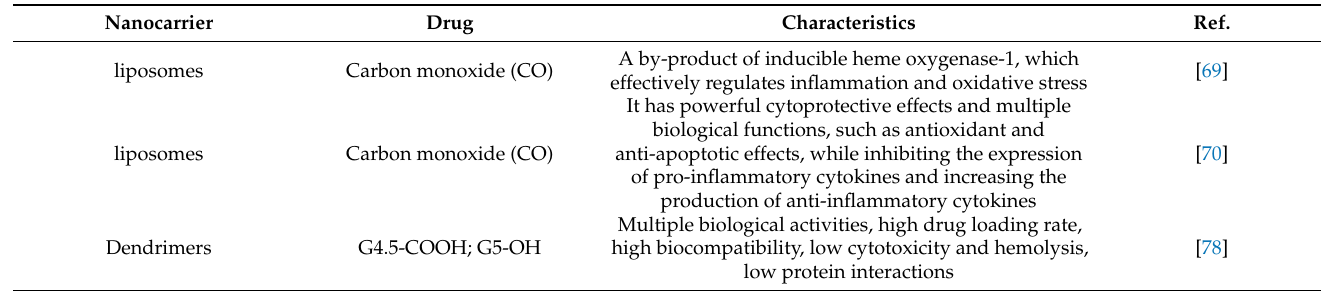
Figure 4. ( a ) Schematic diagram of bilirubin-loaded silk fibroin nanoparticles (BRSNPs) for the treatment of experimental AP. ( b ) Schematic representation of the antioxidant and anti-inflammatory mechanisms of BRSNPs in pancreatic alveolar cells. ( c ) MDA levels in rats after treatment of AP in the BRSNPs group and all other groups. ( d ) SOD levels in rats after treatment of AP in the BRSNPs group and all other groups. && p < 0.01 compared with BR group. ** p < 0.01 compared with model group. ^^ p < 0.01 compared with normal control rats. Reprinted from [88]. Copyright 2020, with permission from Elsevier. Table 1. Nano-drug delivery system loaded with different antioxidant drugs.